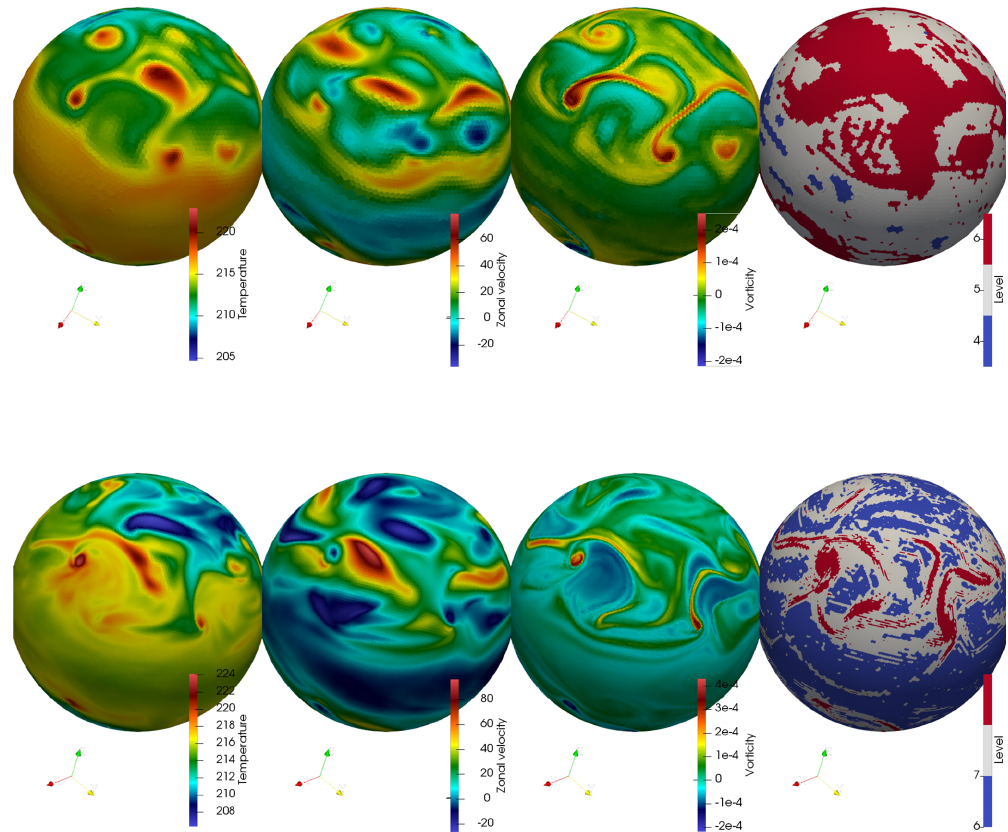
Figure 12. Typical results for the low-resolution (top) and high-resolution (bottom) Held and Suarez general circulation test case at 250hPa. The grid is adapted on the solution with relative error tolerance ε = 0 . 04 in the low-resolution case and ε = 0 . 02 in the high-resolution case. The grid compression ratio is 2.0 for the low-resolution case and 7.5 for the high-resolution